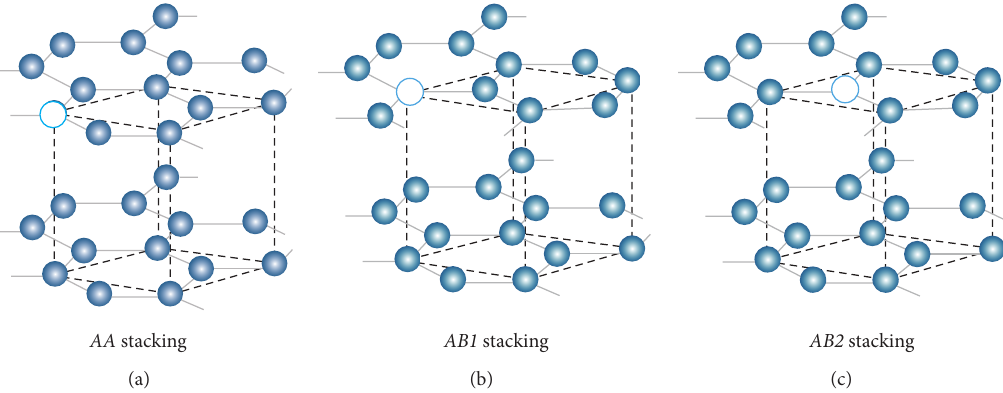
Figure 2: Schematic view of bilayer graphene with AA and AB stacking. The dotted line denotes the two-dimensional unit cell. The open circles denote the substitution sites of dopants. For AB1 and AB2 stacking patterns, see text. Reproduced with permission from [57], copyright 2015, Elsevier.